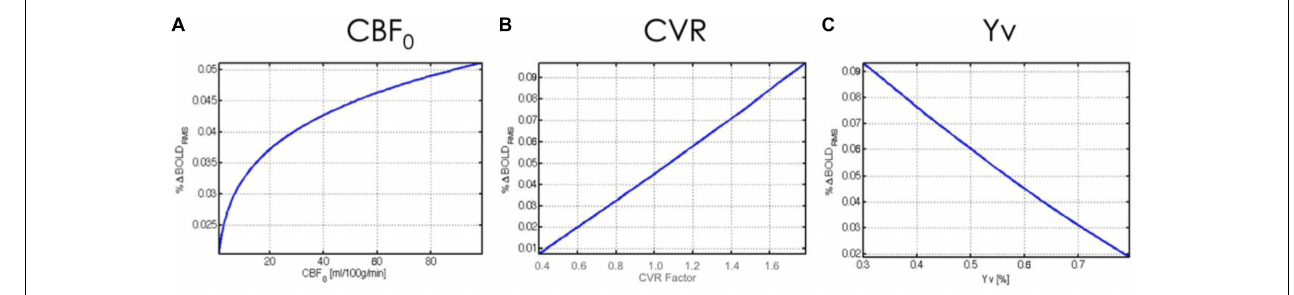
FIGURE 1 | Theoretical relationship between rs-fMRI signal amplitude and physiological variables. The BOLD fMRI fluctuation amplitude (%BOLD RMS ) is plotted against baseline (A) cerebral blood flow (CBF 0 ), (B) cerebrovascular reactivity (CVR), and (C) venous blood oxygenation (Yv). Figure reproduced from Chu et al. (2018) with permission from